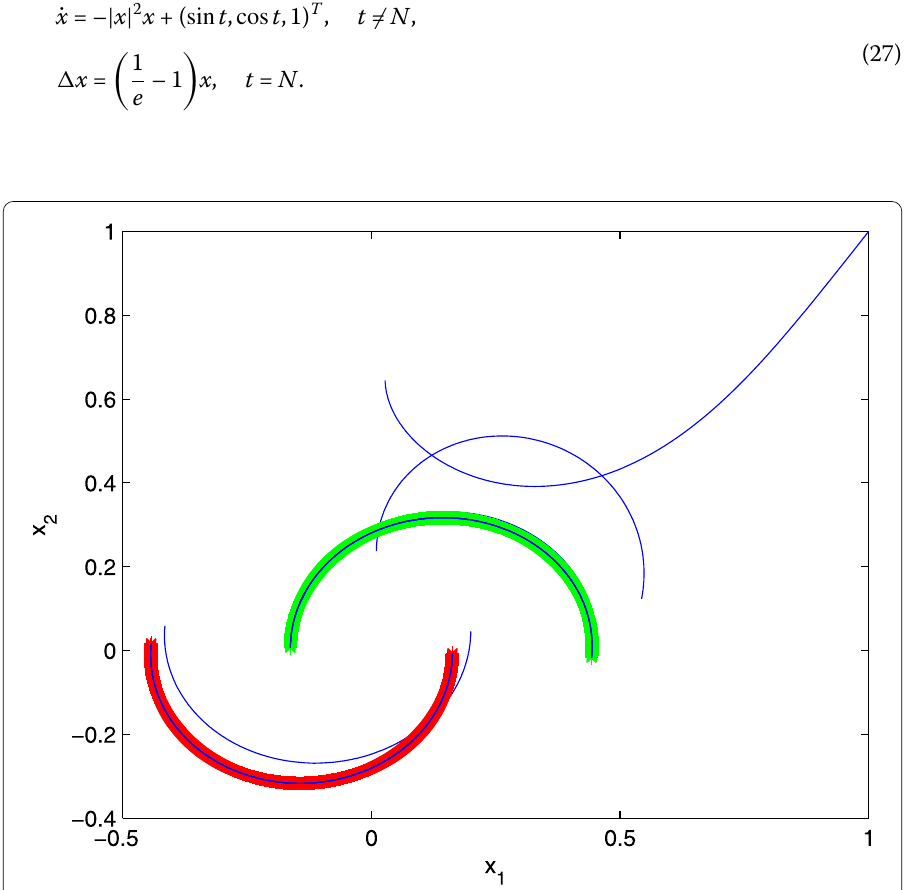
Figure 1 The antiperiodic solution of system (26). The green line is the trajectory of x ( t ) for t ∈ (0,1], the red line corresponds to the trajectory of Qx ( t ) for t ∈